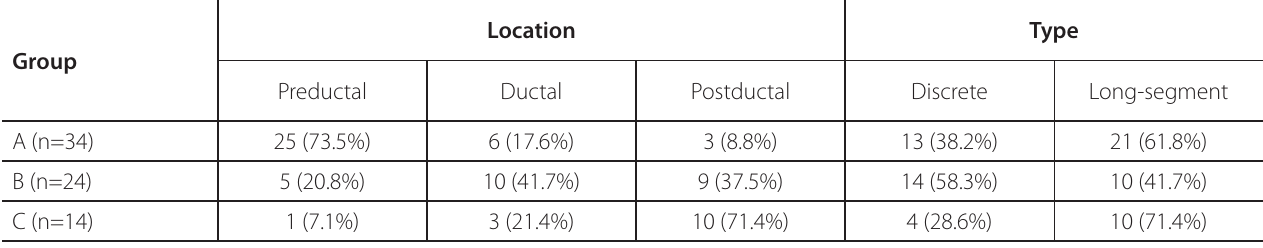
Table 3 . Location and type of coarctation of the aorta during